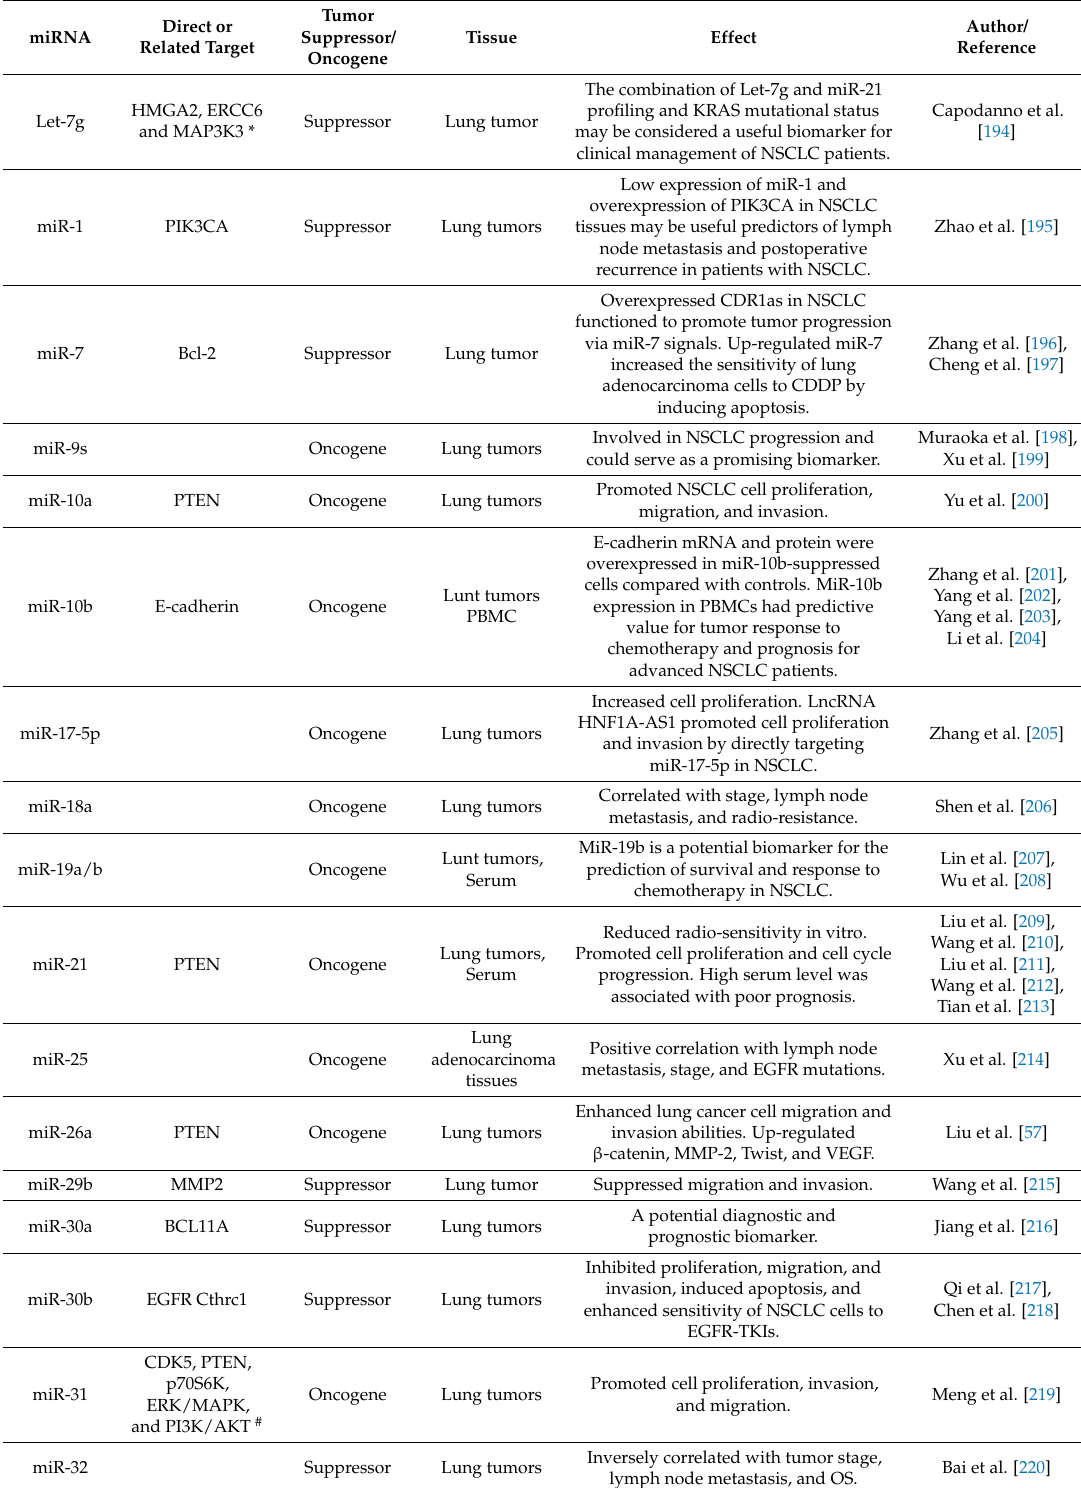
Table 4. Lymph node metastasis-related microRNAs in